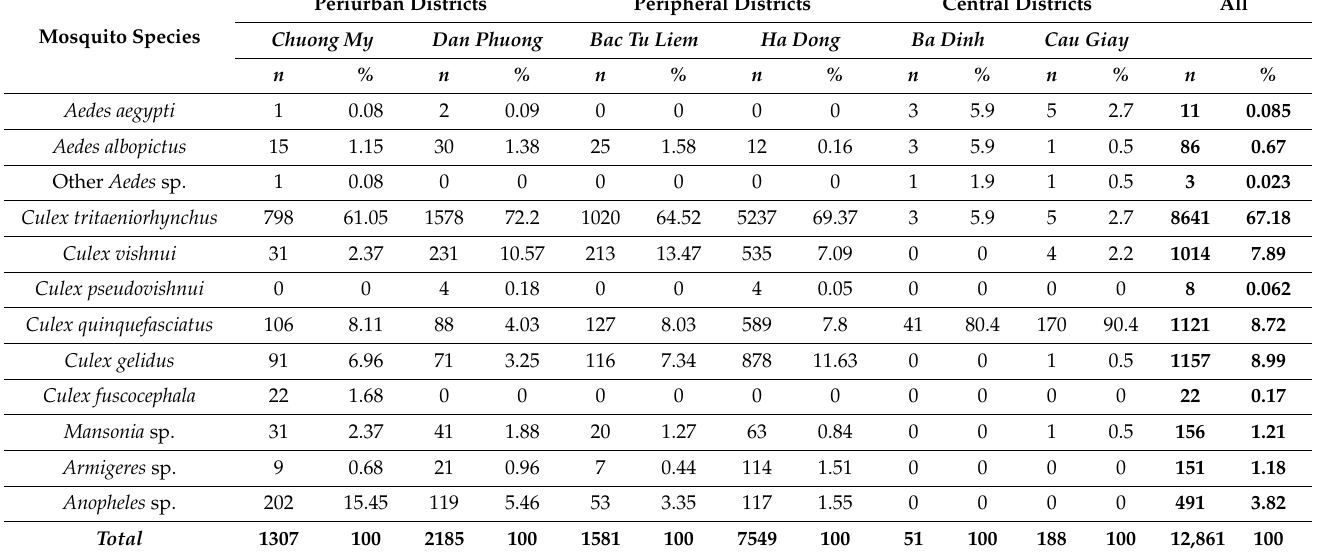
Table 4. Distribution of adult mosquitoes by collection site.